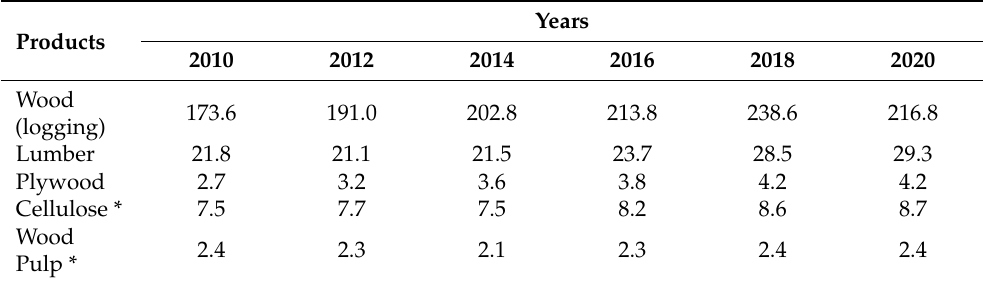
Table 1. Products of the timber industry of Russia (2010–2020), million m 3 /year.